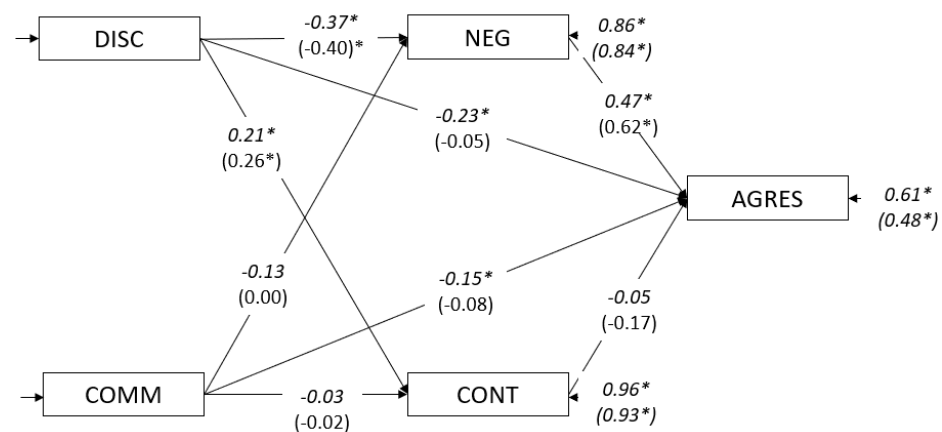
Figure 2. Mediational model for 1–3 year-olds by gender. Note: DISC = discipline; COMM = communication; NEG = negative affect; CONT = effortful control; AGRES = aggressive behavior. Values in italics are for boys; values in parentheses are for girls. * p > 0.05.